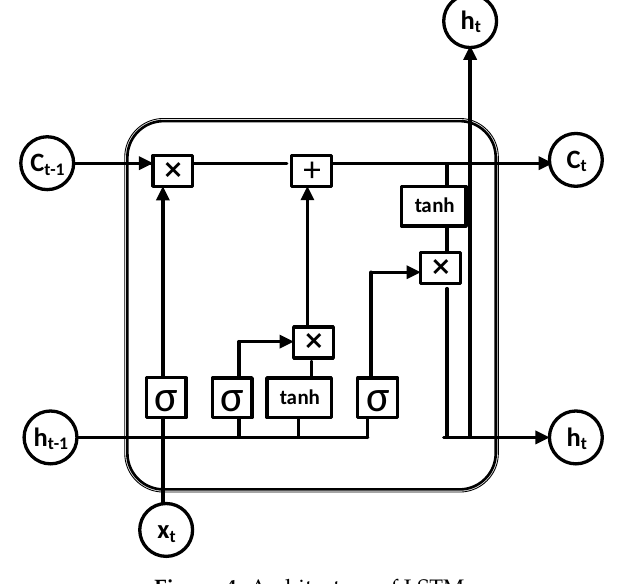
Figure 4. Architecture of